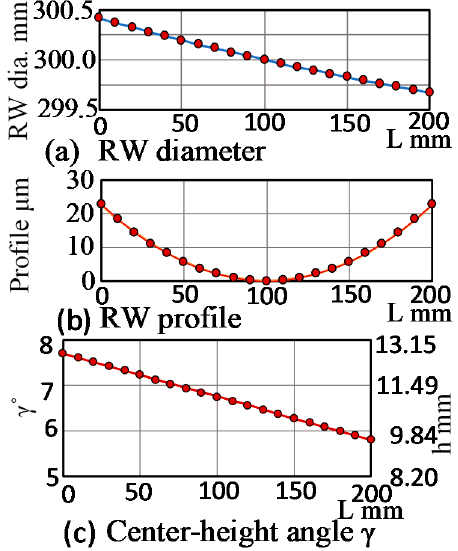
Figure 2. Regulating wheel (RW) profile and center-height angle. ( a ) RW diameter; ( b ) RW profile; ( c ) Center-height angle γ